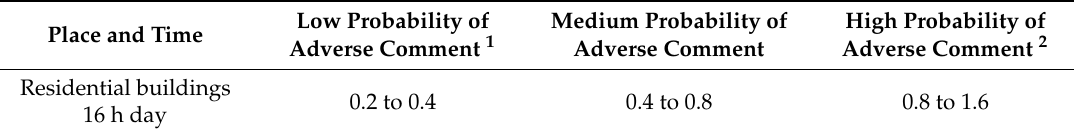
Table 4. Vibration dose value ranges (m / s 1.75 ) which might result in various probabilities of adverse comments within residential